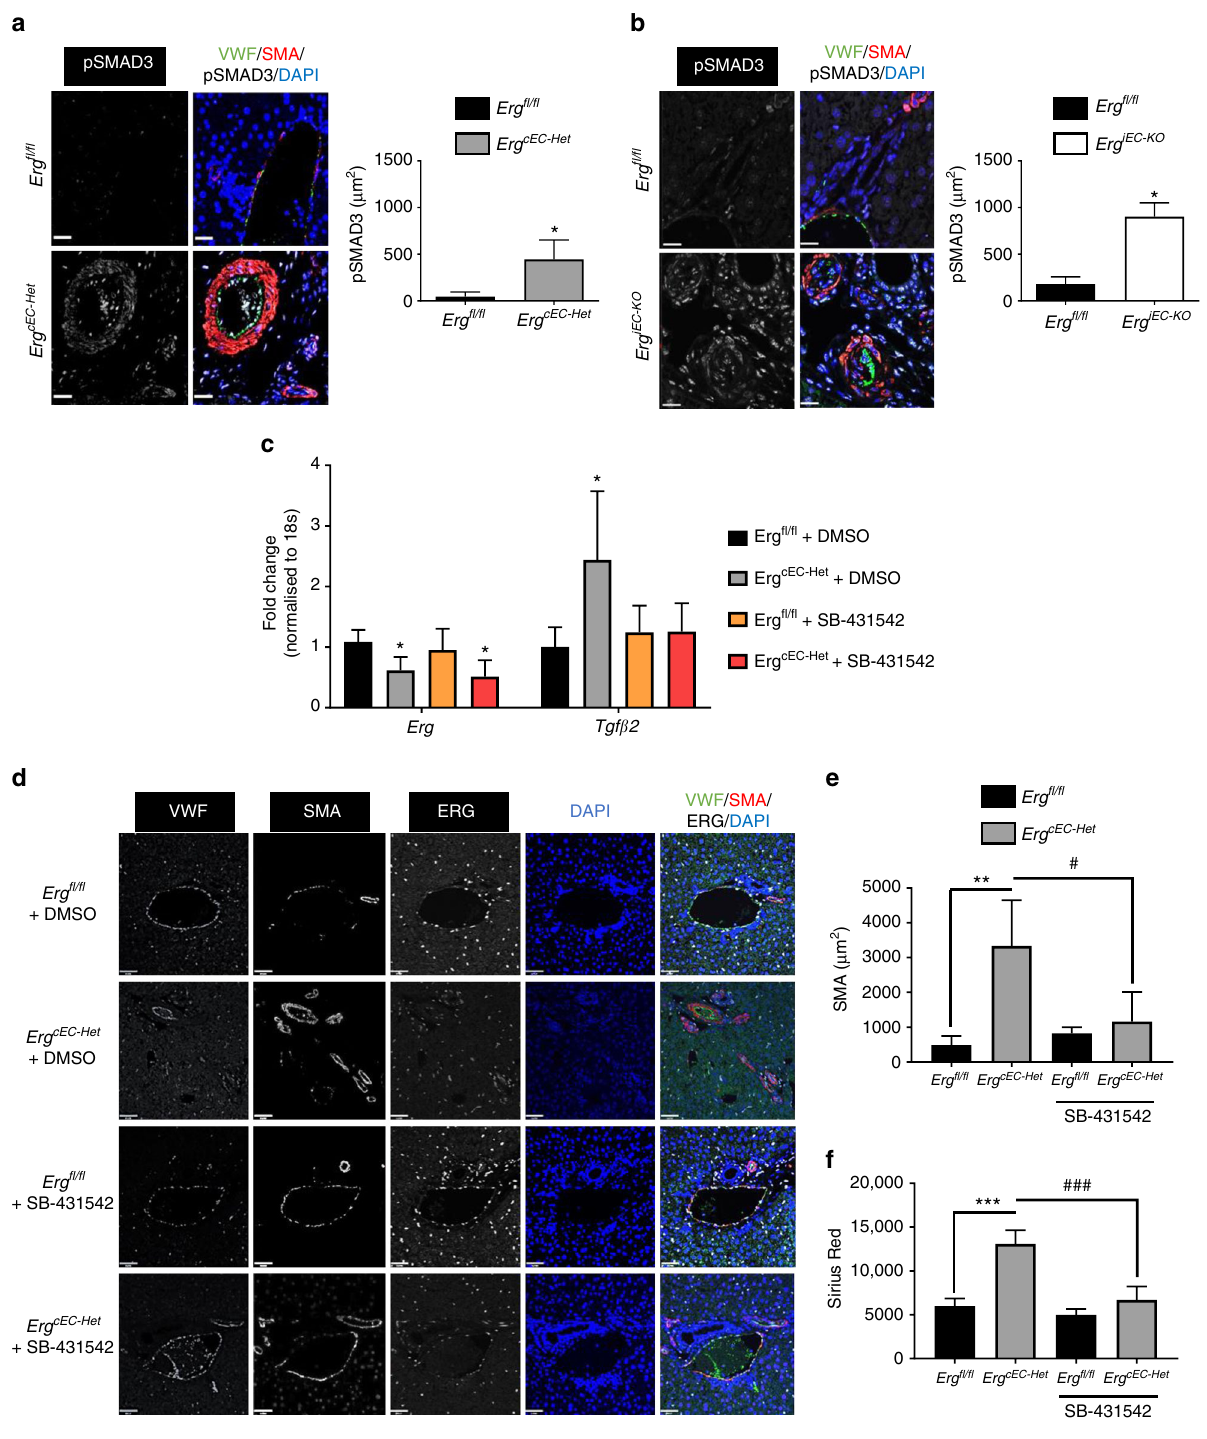
Fig. 5 Peri-portal ERG-de fi cient mouse fi brogenesis phenotype is SMAD3-dependent. a , b SMAD3 activity in portal tract regions was assess by immuno fl uorescence for pSMAD3 (white), VWF (green), SMA (red) and DAPI (blue) in Erg cEC-het and Erg iEC-KO mice, respectively, aged 8 – 10 weeks. Quanti fi cation of pSMAD3 area (three fi elds per mouse, n = 3). SB-431542 (10 mg kg − 1 , i.p) was administered in Erg cEC-het mice three times a week for 2 weeks. Scale bar 20 μ m. c mRNA was isolated from CD31 + murine EC isolated from lung tissue and analysed by qPCR ( n = 4). Data were compared to EC from Erg fl / fl littermate controls (*) or to DMSO treated Erg cEC-het (#) by one-way ANOVA and Bonferroni multiple comparison post-test. d Representative images of portal tract VWF (grey scale; green in merge), SMA (grey scale; red in merge), ERG (white), DAPI (blue) and merged panels (Scale bar 50 µ m). e Quanti fi cation of SMA expression (5 fi elds per mouse, n = 4). f Quantitative analysis of Picro-sirius red positive tissue, using polarised light (more representative images in Supplementary Fig. 8B). Data were compared to Erg fl / fl littermate controls (*) or to DMSO treated Erg cEC-het (#) by one-way ANOVA and Bonferroni multiple comparison post-test. All graphical data are mean ± s.e.m., * or # P < 0.05, ** or ## P < 0.01, *** or ### P <